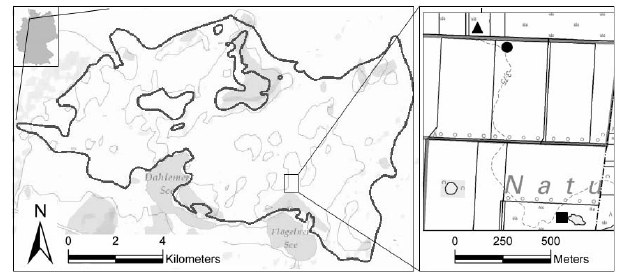
Fig. 1. Location of the Ahlen-Falkenberger peat bog within Ger- many (upper left small map), and the sites within the inner peat bog complex of the Ahlen-Falkenberger peat bog (left map). On the right map the black triangle ( N ) denotes the extensively used site (GE), the circle ( • ) the intensively used one (GI), and the square ( (cid:4) ) the natural one within a nature reserve area (NW) (LGLN,